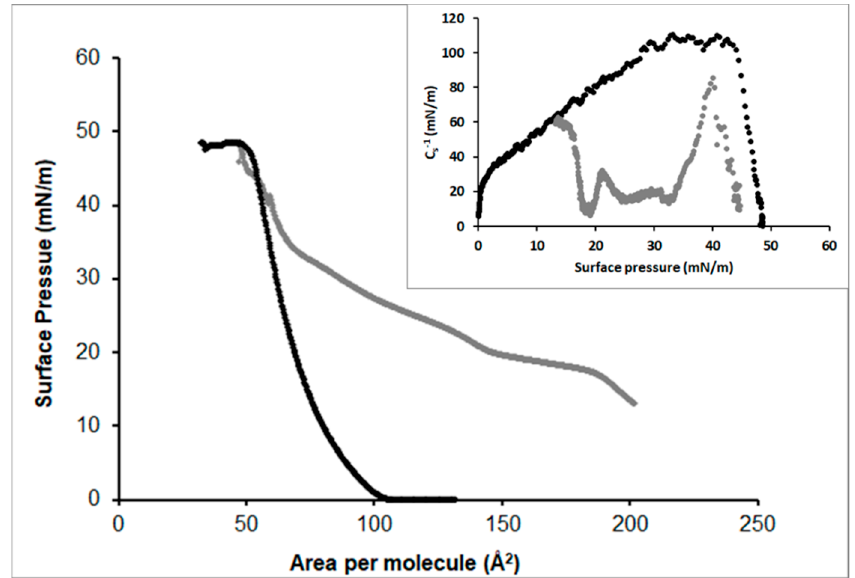
Figure 5. Surface pressure-area isotherms for POPC in the absence (black) and in the presence (grey) of lysozyme. Inset: Elastic modulus curves from the isotherms of Figure 5 for POPC in the absence (black) and in the presence (grey) of lysozyme.